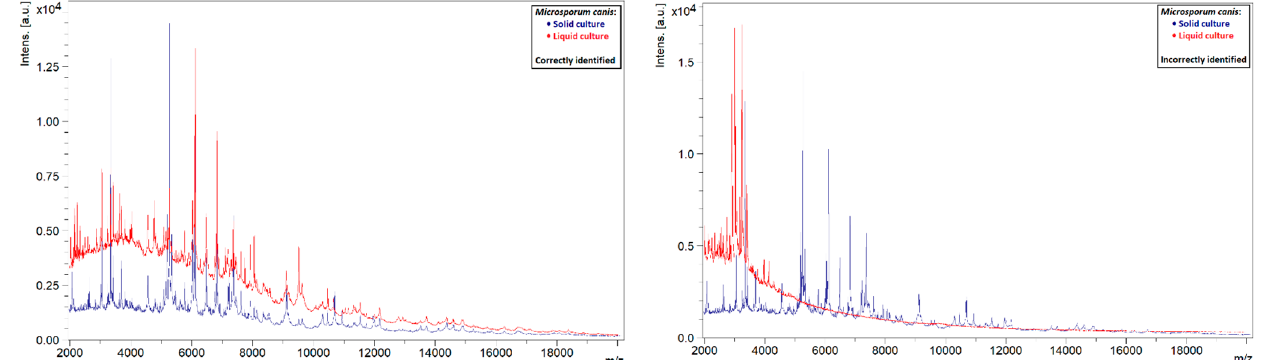
Figure 5. Comparison of the spectra of solid and liquid cultures of M. audouinii , on the left a correctly identified liquid culture and on the right an incorrectly identified liquid culture.